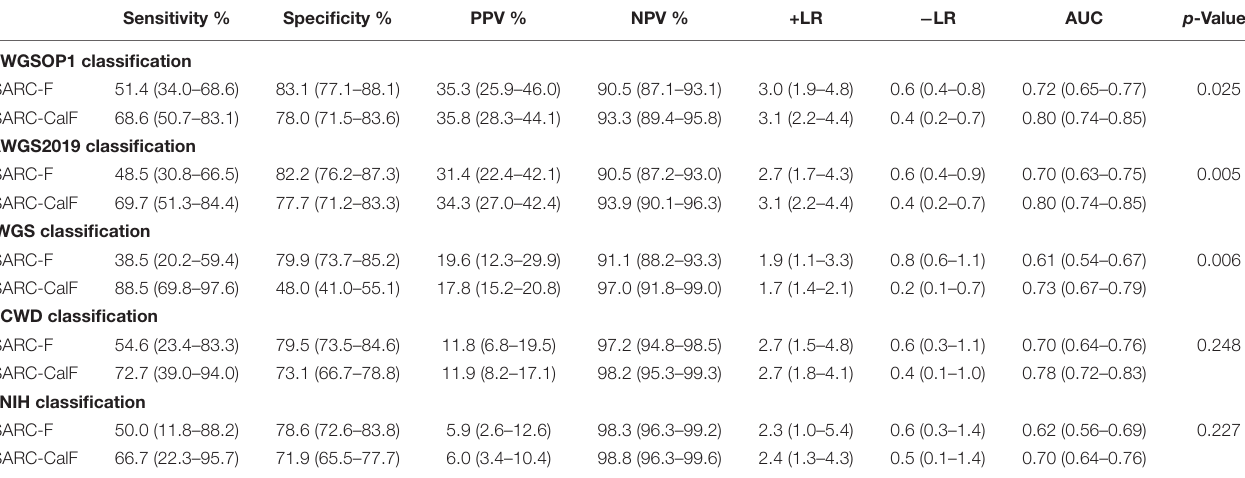
TABLE 5 | Analysis of the curves of sensitivity, specificity, PPV, VPN, +LR, and − LR and ROC for the validation of SARC-F and SARC-CalF against various criteria of sarcopenia in women. Sensitivity